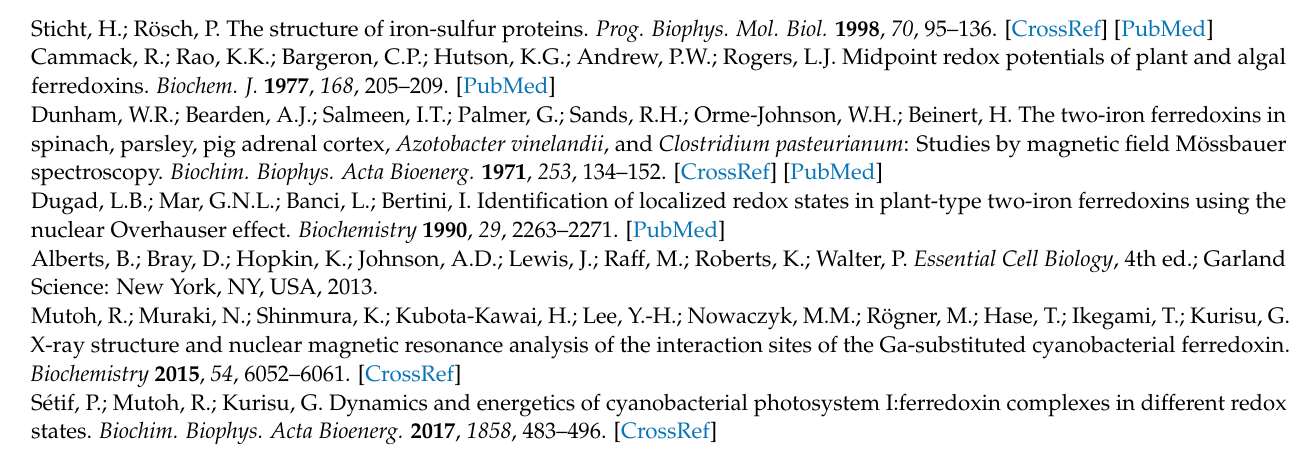
Figure S1: The dominant motion along PC1 up to 1.5 ns after the start of the production MD simula- tion; Figure S2: Geometry of Models 1 and 2 constructed based on the crystal structure by MCPB.py; Table S3: Cartesian coordinates of optimized geometry of Model 1 with oxidized state; Table S4: Cartesian coordinates of optimized geometry of Model 1 with reduced state; Table S5: Input files